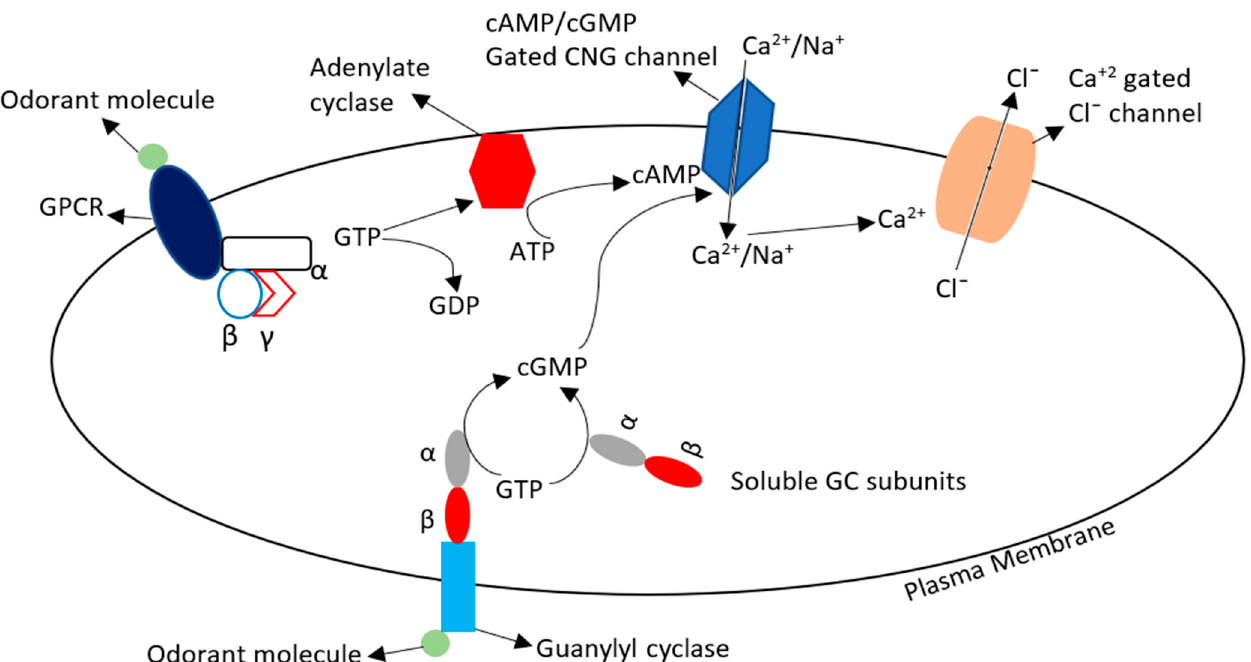
Figure 2. General mechanism of odorant receptor activation and signal transduction pathway. Odorant molecules combined with membrane GPCR and their cytosolic subunit α activates the adenylate cyclase (AC) by converting GTP into GDP. This AC mediates conversion of ATP into cAMP which causes opening of CNG channels. Similarly, when Odorant molecule interacts with (guanylyl cyclase) GC their cytosolic subunits convert the GTP to cGMP which enhances the opening of CNG channels. Ca 2+ enters the cell through these CNG channels and increased Ca 2+ concentration influences the opening of Ca 2+ gated chloride (Cl − ) channels. So, the influx of positive ion (Ca 2+ ) and efflux of negative ion (Cl − ) changes the membrane potential causing waves of polarization and depolarization which helps in sperm motility. GTP, guanosine triphosphate; GDP, guanosine monophosphate; ATP, adenosine triphosphate; cAMP, cyclic adenosine monophosphate; cGMP, cyclic guanosine monophosphate.